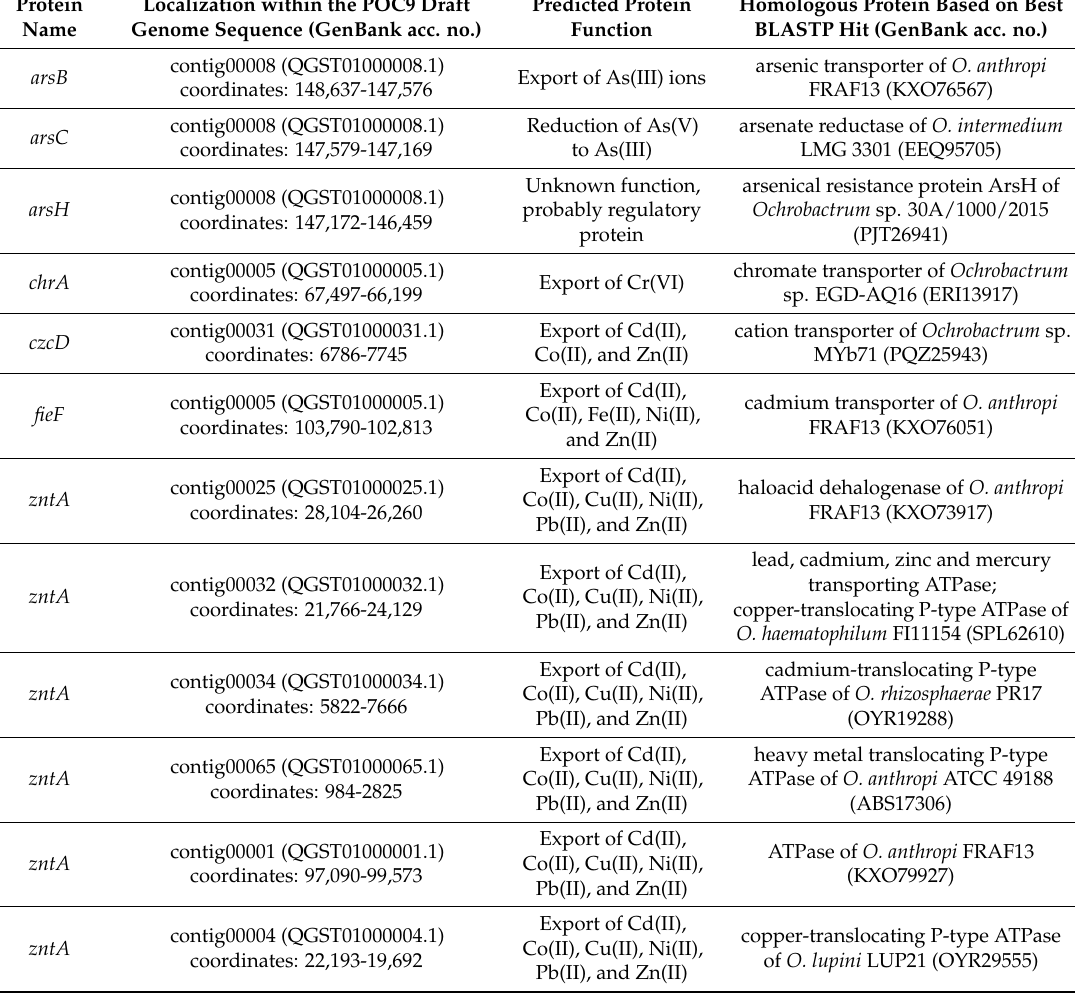
Table 4. Heavy metal resistance genes identified within the Ochrobactrum sp. POC9 draft genome. Protein